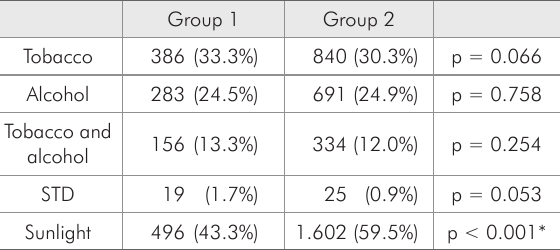
Table 1 - Main risk factors for oral cancer of patients exam- ined by primary health care personnel according to group.